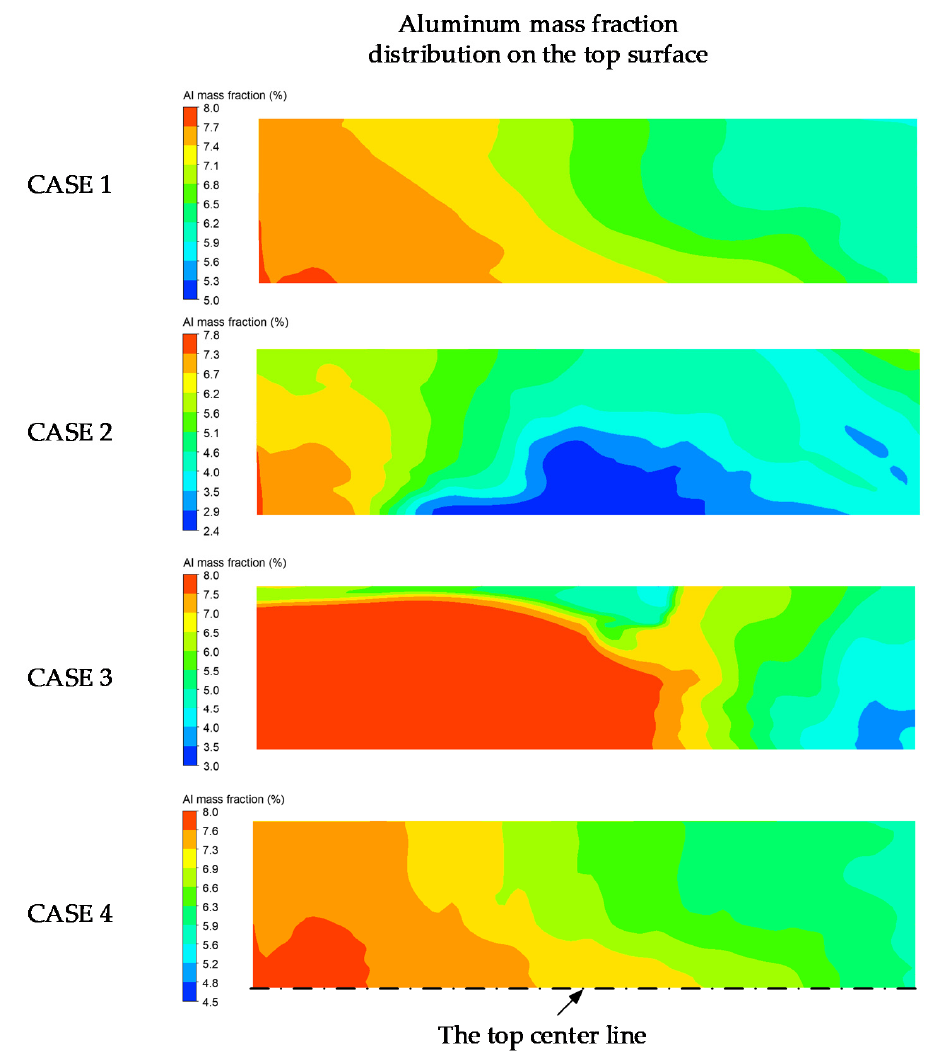
Figure 9. Al mass fraction fields with respect to the four scanning strategies after 550 s.